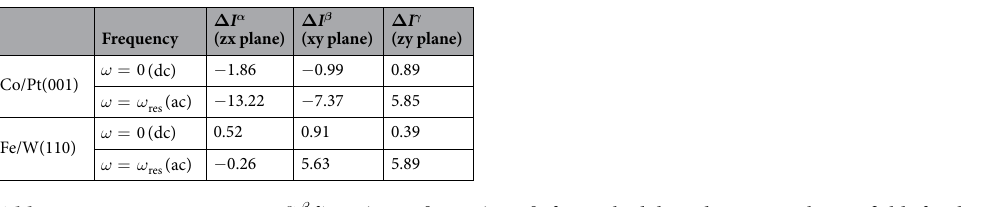
Table 1. Magnetoresistances ∆ = ′ − ′ α β γ ω ω   I I I (90 ) (0 ) , , different rotation angles represented in the central panel of Fig.